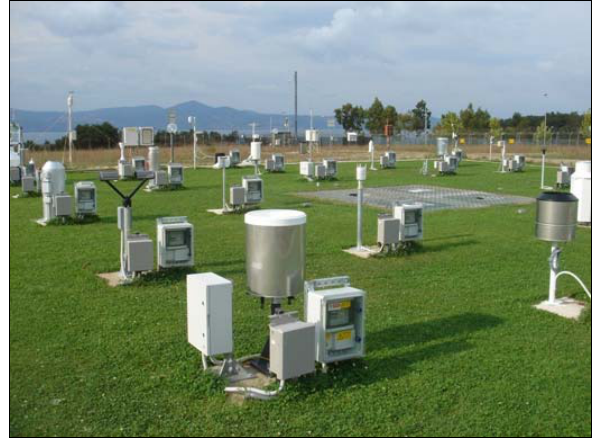
Fig. 2 : The WMO Field Intercomparison test bed in Vigna di Valle (Italy). Fig. 2. The WMO Field Intercomparison test bed in Vigna di Valle